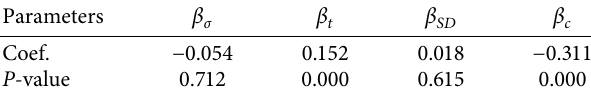
Figure 6: The relationship between A and B. Table 1: Parameter calibration results of the mean-variance model.